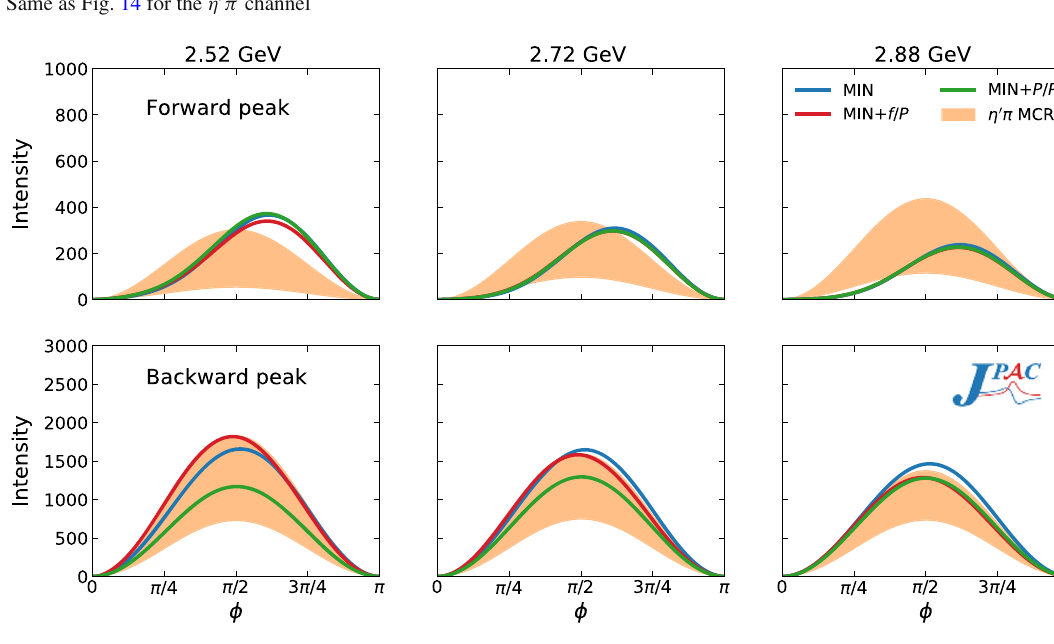
Fig. 19 Same as Fig. 15 for η (cid:2)